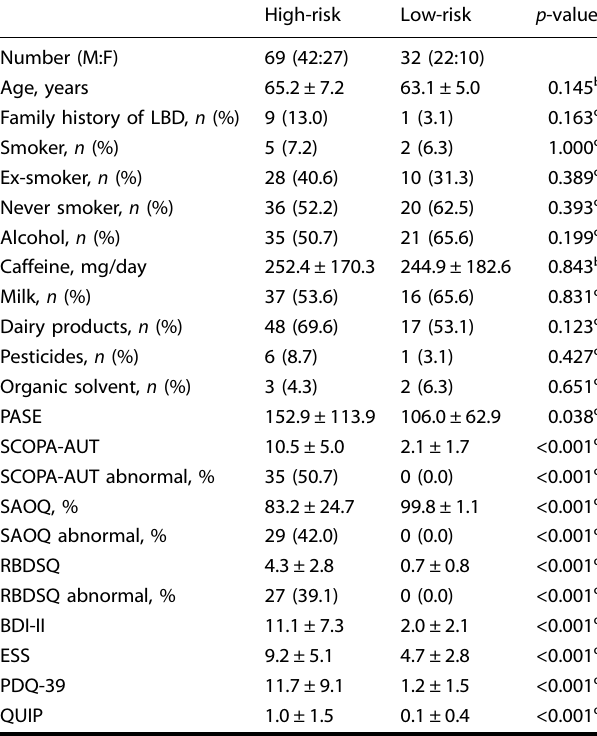
Table 1. Background characteristics of the participants. Table 2. Lewy body disease-related neurological and imaging indices of the